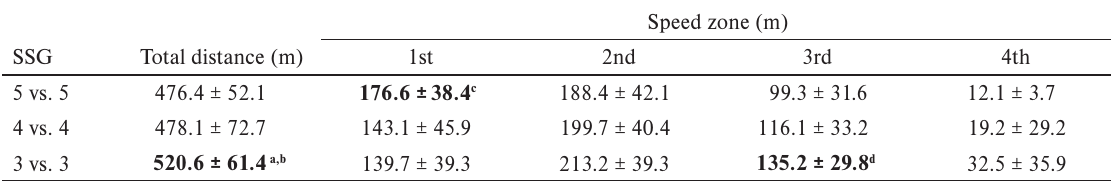
Note. SSG = small sided games. a significant difference between SSG 3 vs. 3 and 5 vs. 5 ( p = .043); b significant difference between SSG 3 vs. 3 and 4 vs. 4 ( p = .041); c significant difference between SSG 5 vs. 5 and 3 vs. 3 ( p = .034); d significant dif- ference between SSG 3 vs. 3 and 5 vs. 5 ( p =.044). Bold face indicates a significant